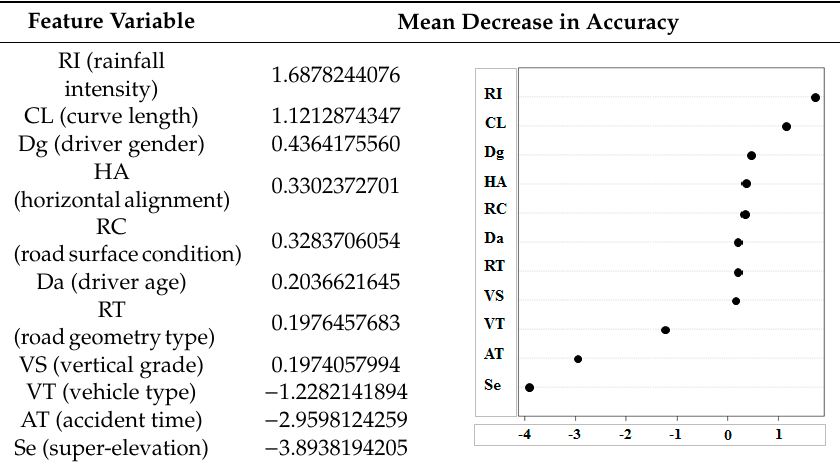
Table 4. Importance values (mean decrease in accuracy).